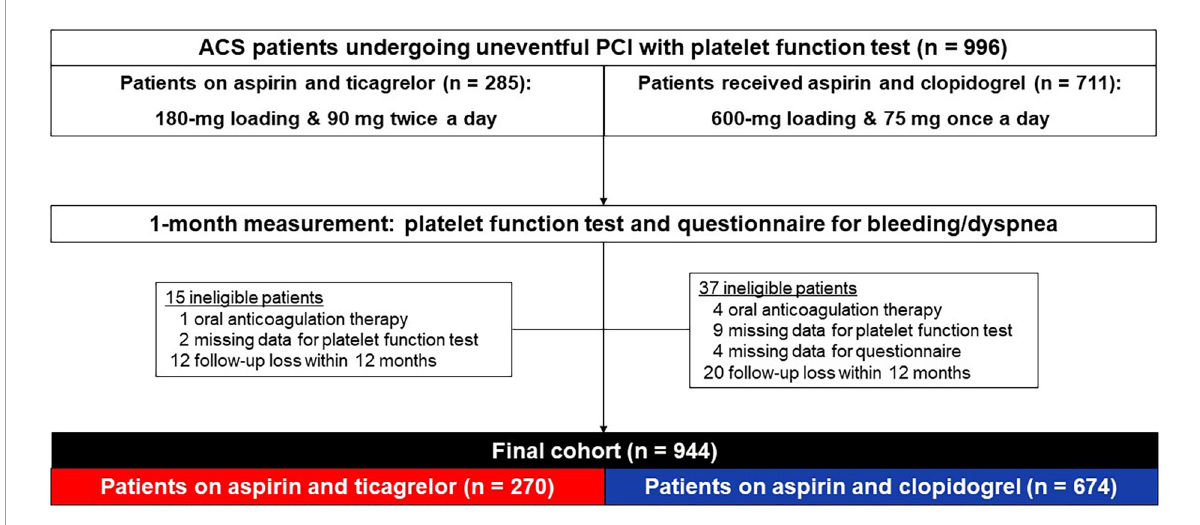
FIGURE1 Flow diagram. ACS, acute coronary syndrome; PCI, percutaneous coronary intervention.